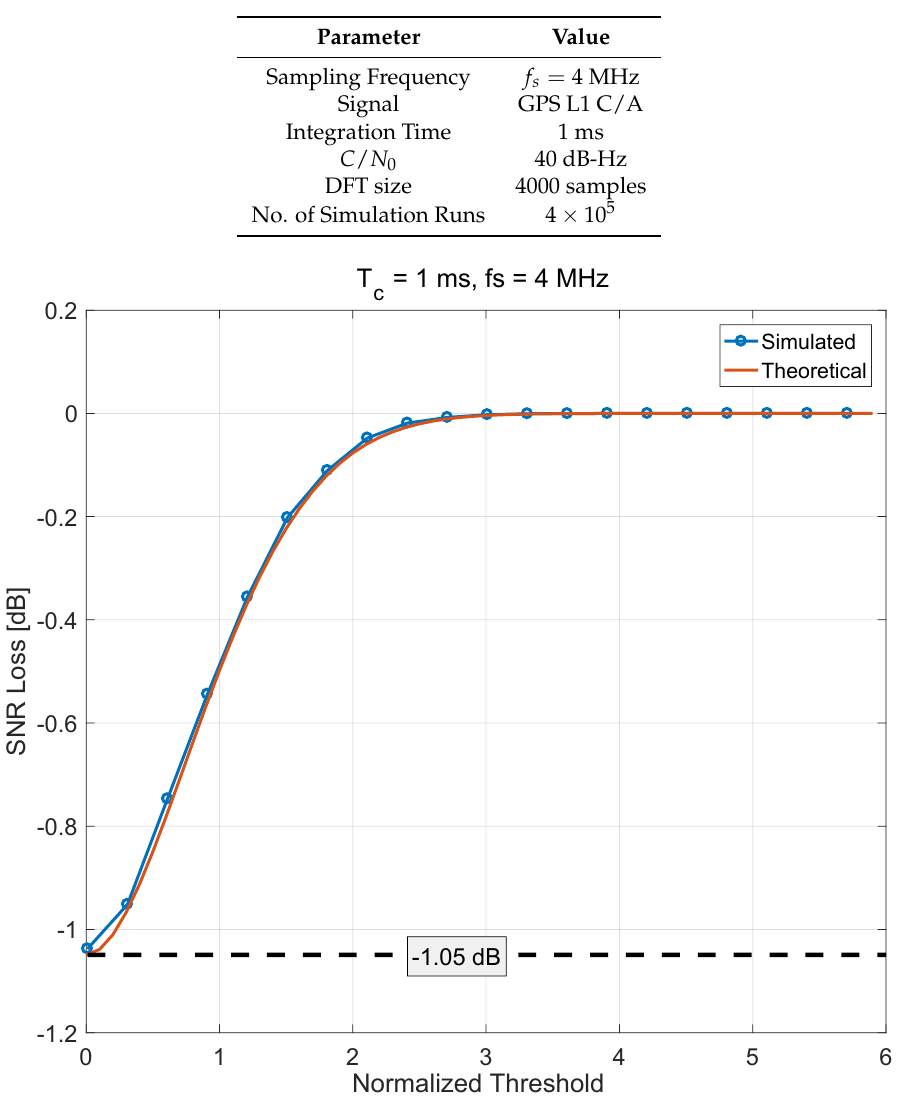
: comparison between σ